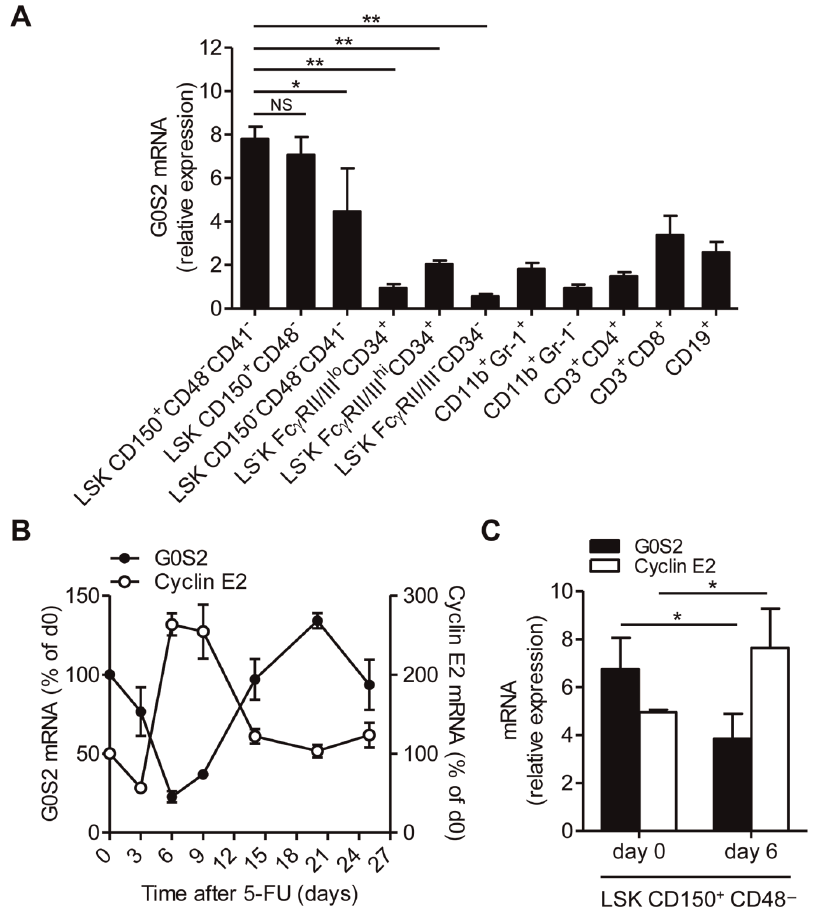
Figure 1. G0S2 is expressed in dormant hematopoietic stem cells. (A) G0S2 transcripts were measured by quantitative real-time PCR in bone marrow hematopoietic stem and progenitor cells based on SLAM markers and mature myeloid and lymphoid cells purified from the spleen ( n =3). Statistical significance is indicated between HSCs and progenitor cells (MPP, CMP, GMP, MEP). (B) Expression of G0S2 and cyclin E2 in BM cells isolated at different times after administration of a single dose of 5-FU in C57BL/6 mice. The relative expression levels of G0S2 and cyclin E2 are shown as percentages of basal levels ( n =3–4). (C) Transcript levels of G0S2 and cyclin E2 were measured in LSK CD150 + CD48 2 cells purified from untreated or 5-FU-treated (day 6) mice ( n =3). The data represent the mean and standard deviation of each experiment. *, P , 0.05 and **, P , 0.01 (two-tailed Student’s t -test).